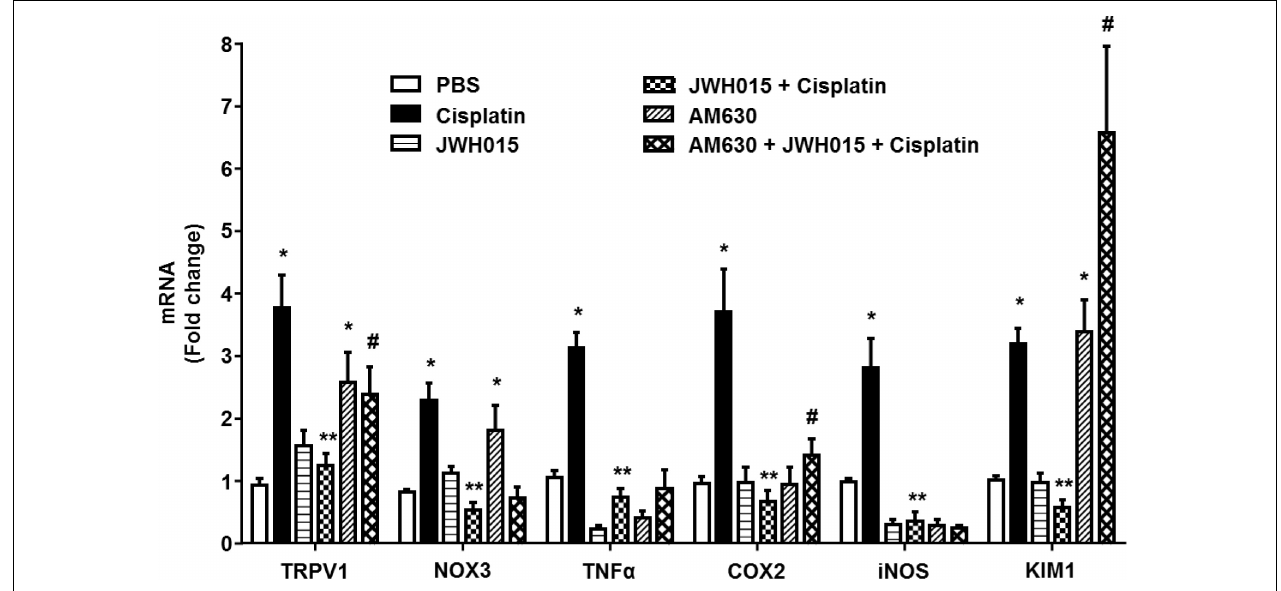
FIGURE 5 | Activation of CB2R by JWH015 mitigates cisplatin-induced inflammation in the rat cochlea. Snap frozen cochlea from treated animals were used for total RNA extraction which was then converted to cDNA and used for real-time RT-PCR for the expression of TRPV1 , NOX3 , TNF- α , COX2 , iNOS, and KIM1. Housekeeping gene, GAPDH, was used for normalization. Cisplatin significantly increased the expression of all the genes tested. The expression of these genes were significantly reduced in rats pre-treated with JWH015 followed by cisplatin. Administration of CB2R antagonist, AM630, alone increased the expression of TRPV1 , NOX3, and KIM1 . Data is plotted as mean fold change ± SEM ( n ≥ 5). ∗ p < 0.05 vs. vehicle; ∗∗ p < 0.05 vs. cisplatin; and # p < 0.05 vs. JWH015 + cisplatin (one-way